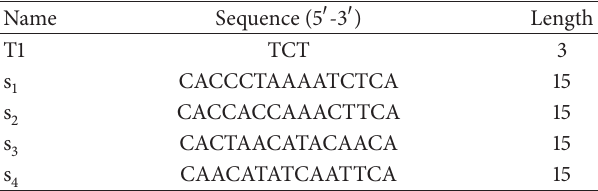
Table 2: Components samples.